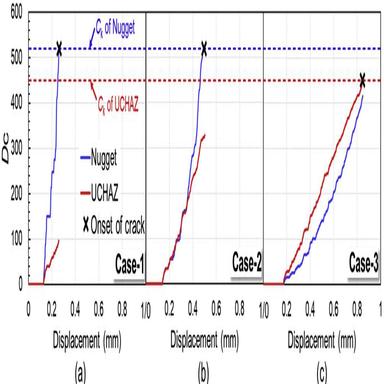
Calculated damage accumulation Dc for nugget and UCHAZ as functions of the applied displacement during the tensile-shear test. (a) Case-1, (b) Case-2, (c) Case-3.